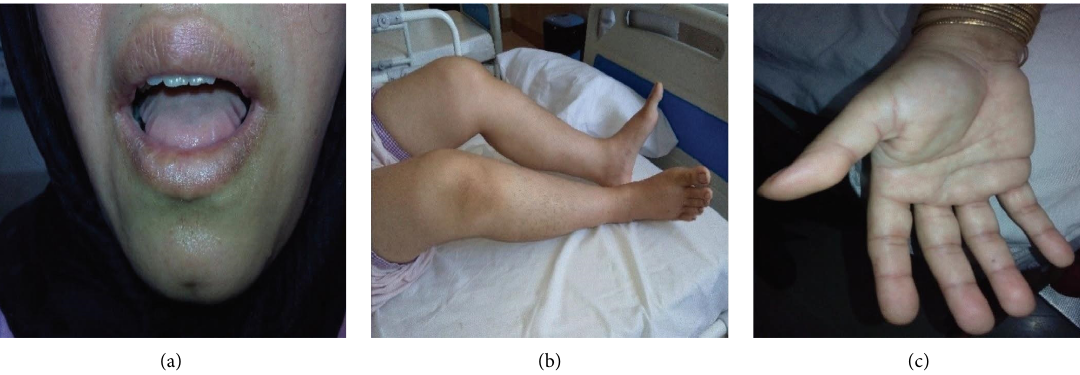
Figure 1: (a) Macroglossia and lateral scalloping of the tongue, (b) fexion contracture of the knee joint, and (c) skin stifness of palms and